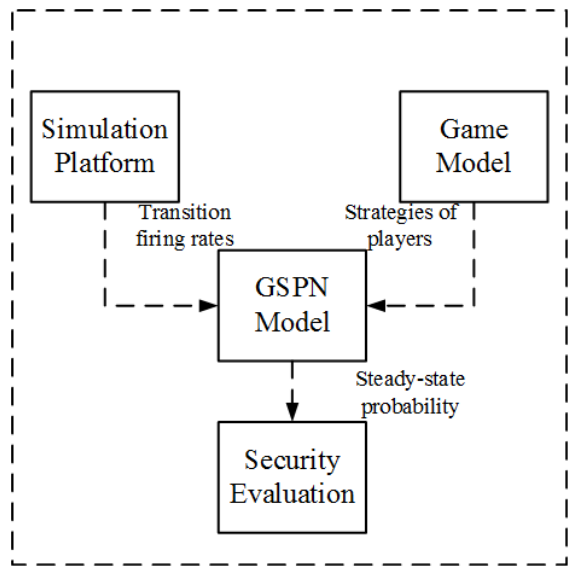
Figure 2. Overall framework of the